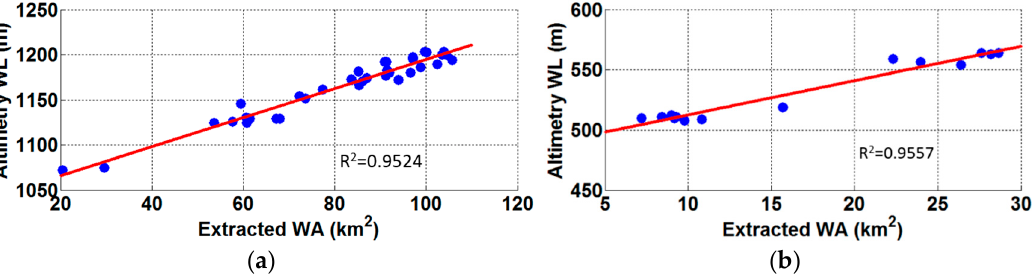
Figure 5. Relationships between WL and WA of: ( a ) Xiaowan Dam; and ( b ) Jinghong Dam. Blue points: Coincident WL and WA measurements (acquired within five days). Red line: linear regression of blue points. R 2 : R square between WL and WA.